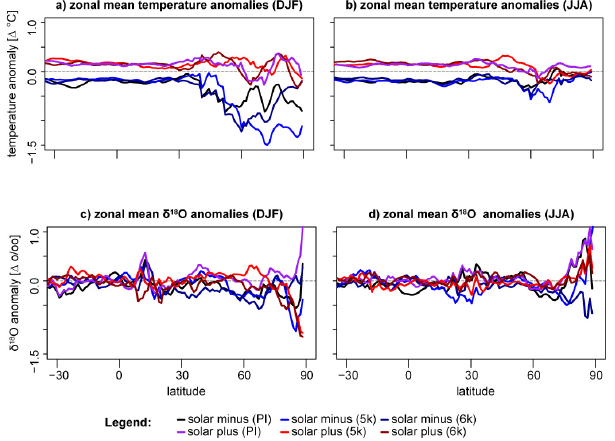
Fig. 10. Zonal mean temperature and δ 18 O precipitation anomalies during boreal summer (JJA) and winter (DJF) due to changes in solar activity (see text). Redish lines visualize the influence of an increased solar activity, bluish lines represent a weak activity of the sun.